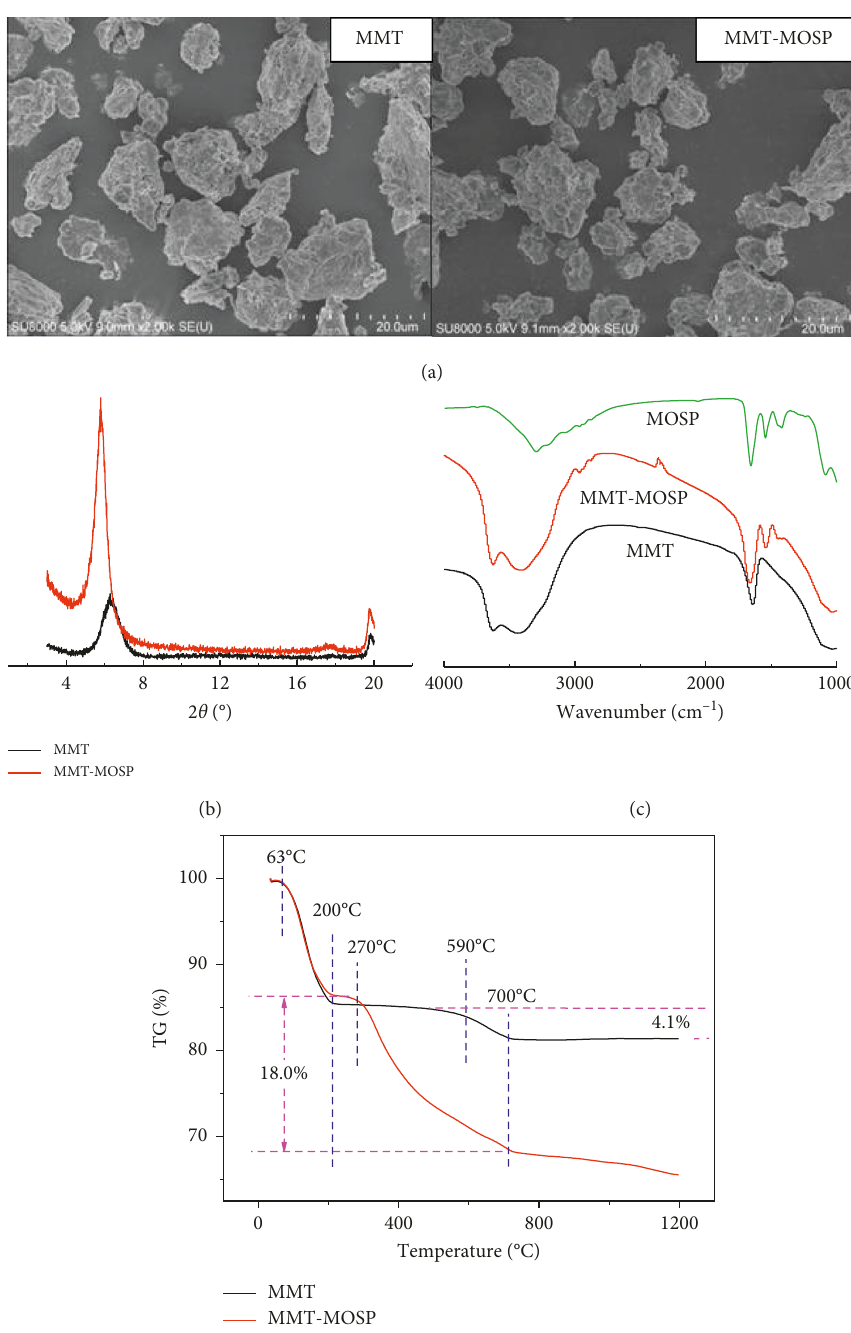
Figure 2: SEM of MMTand MOSP-MMT (a); XRD of MMTand MOSP-MMT (b); FTIR spectra of MMT, MOSP, and MOSP-MMT (c); TG of MMT and MOSP-MMT